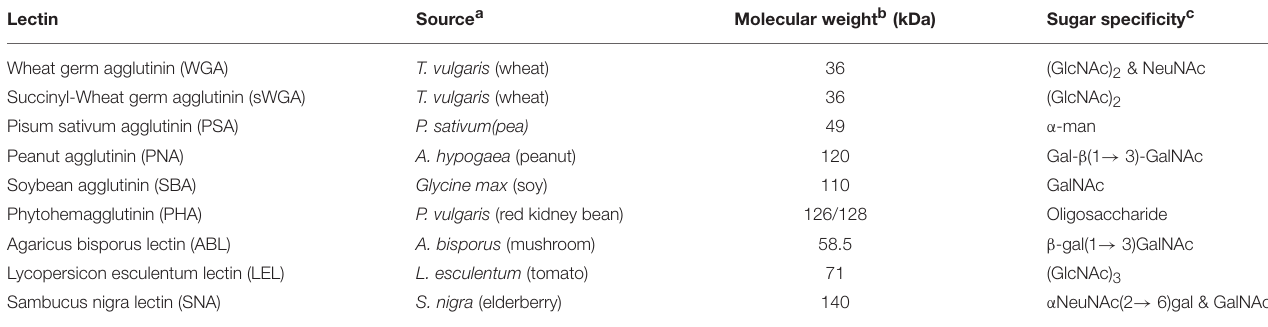
TABLE 1 | All lectins used and their name, source, molecular weight, and sugar specificities.